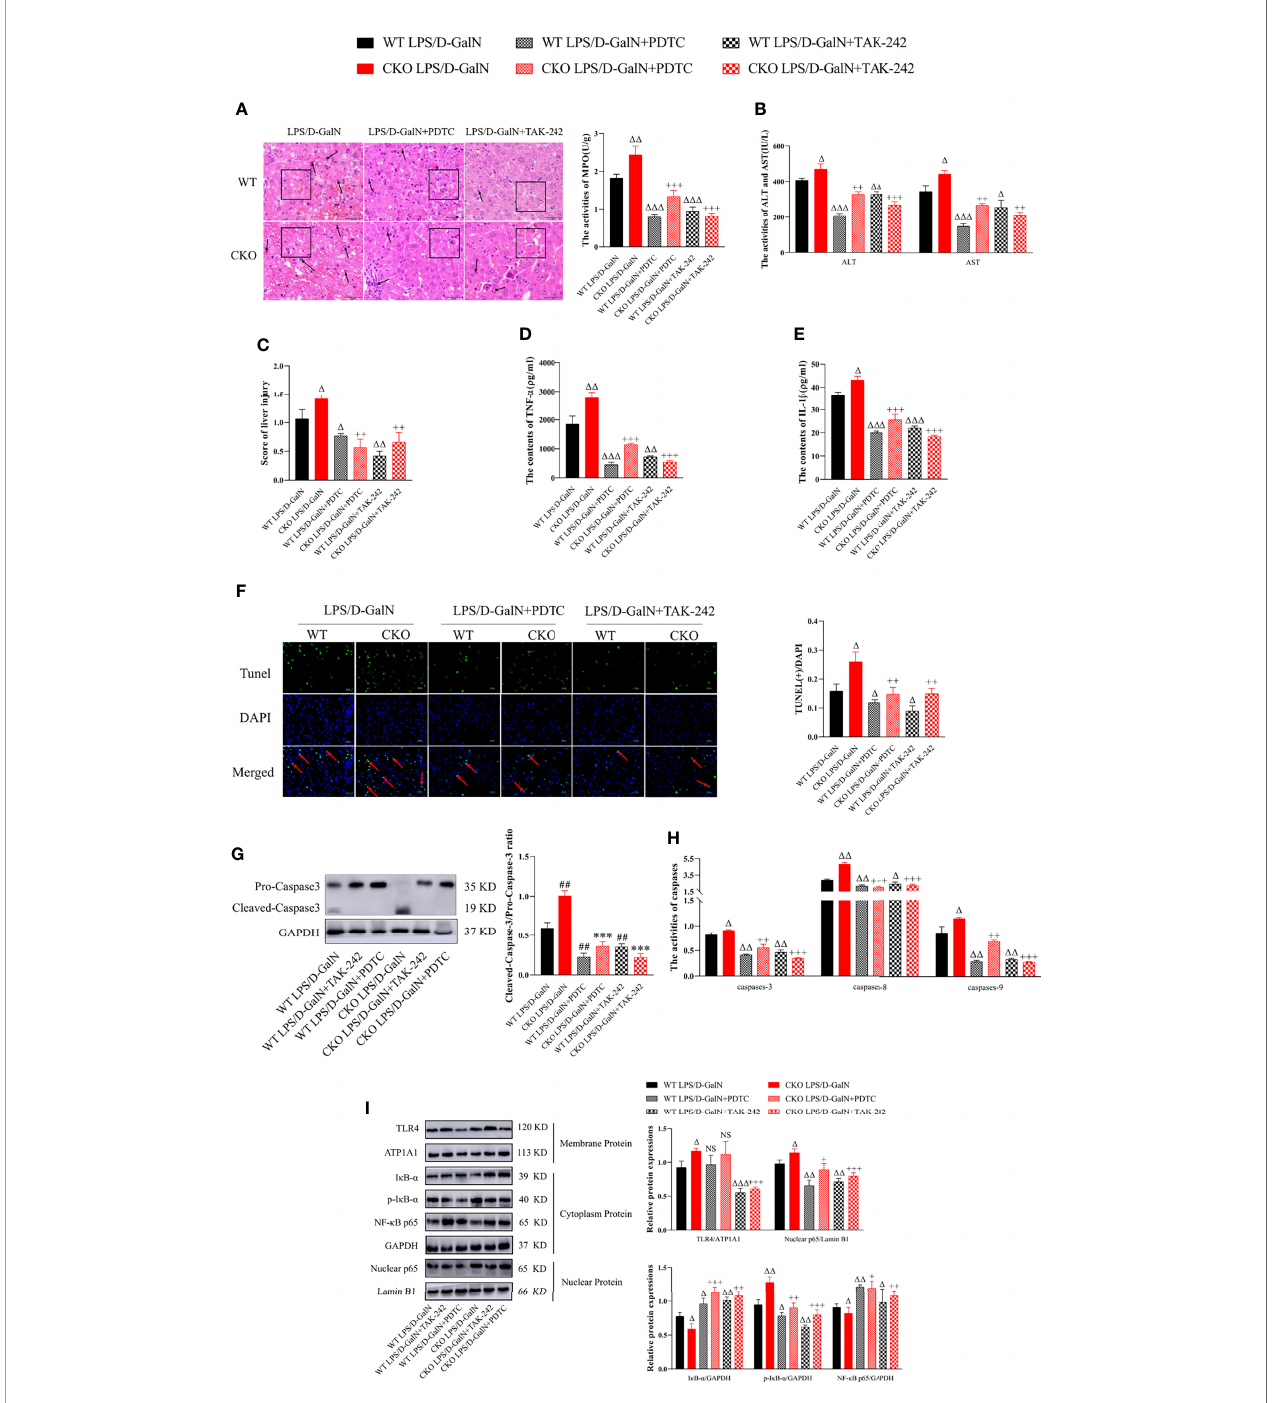
FIGURE 4 | PDTC and TAK-242 could partially counteract TLR4/NF- k B signaling activation induced by PEBP4 CKO in ALI. (A) : Histological changes of liver tissue (H&E staining, ×400) and the injury scores of HE was quanti fi es, ↑ for in fl ammatory cell in fi ltration, □ for hepatocyte degeneration and red blood cell in fi ltration. (B) : Serum ALT/AST activities (n = 6). (C) : Liver MPO activities (n = 6). (D, E) : The contents of serum TNF- a and IL-1 b (n = 6). (F) : TUNEL staining results of liver tissue (×400) and positive cells of TUNEL were quanti fi ed, ↑ for TUNEL (+) cells. (G) : The expressions of cleaved caspase-3/pro – caspase-3 (n = 3); (H) : The activities of caspase-3, -8, and -9 in liver tissue (n = 6). (I) : The expression levels of TLR4, I k B- a , p-I k B- a , NF- k B p65, and nuclear protein NF- k B p65 were detected by western blotting, and the gray levels were analyzed (n = 3). Data are presented as mean ± SD values. D P < 0.05, DD P < 0.01, and DDD P < 0.001 compared to the WT LPS/D-GalN group, + P < 0.05, ++ P < 0.01, and +++ P < 0.001 compared to CKO LPS/D-GalN group. NS, no signi fi